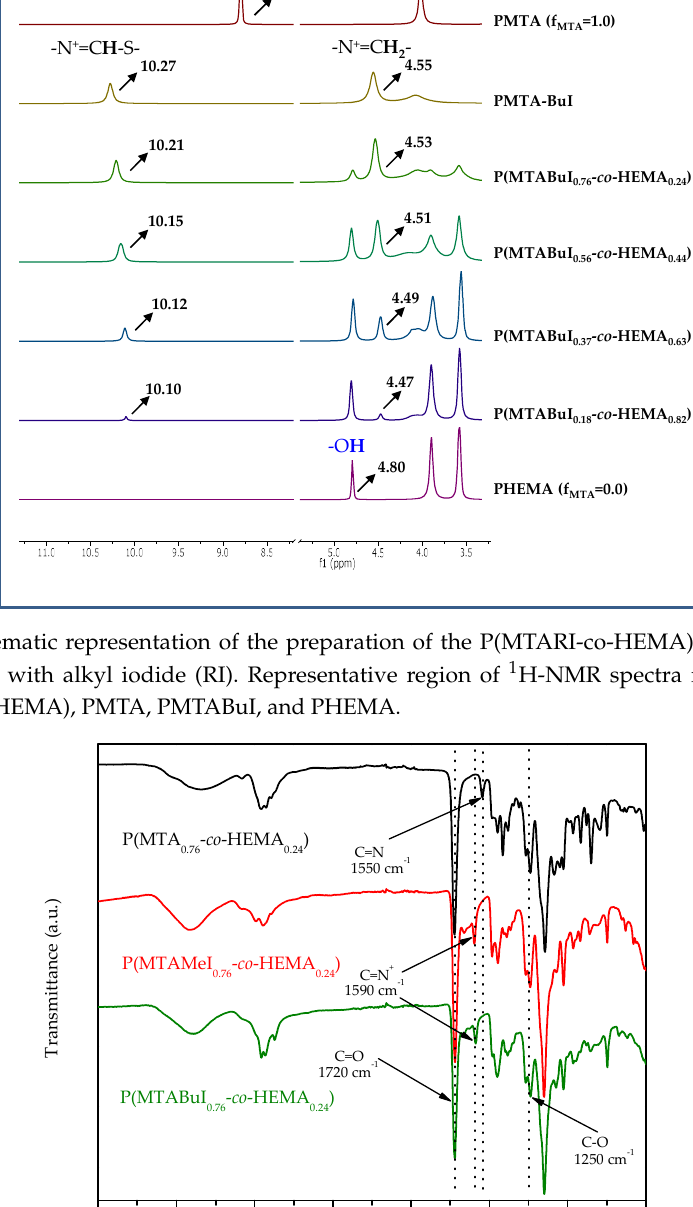
Figure 2. Attenuated total reflection Fourier-transform infrared spectroscopy (ATR-FTIR) spectra of P(MTA 0.8 - co -HEMA 0.2 ), P(MTAMeI 0.8 - co -HEMA 0.2 ), and P(MTABuI 0.8 - co -HEMA 0.2 ).